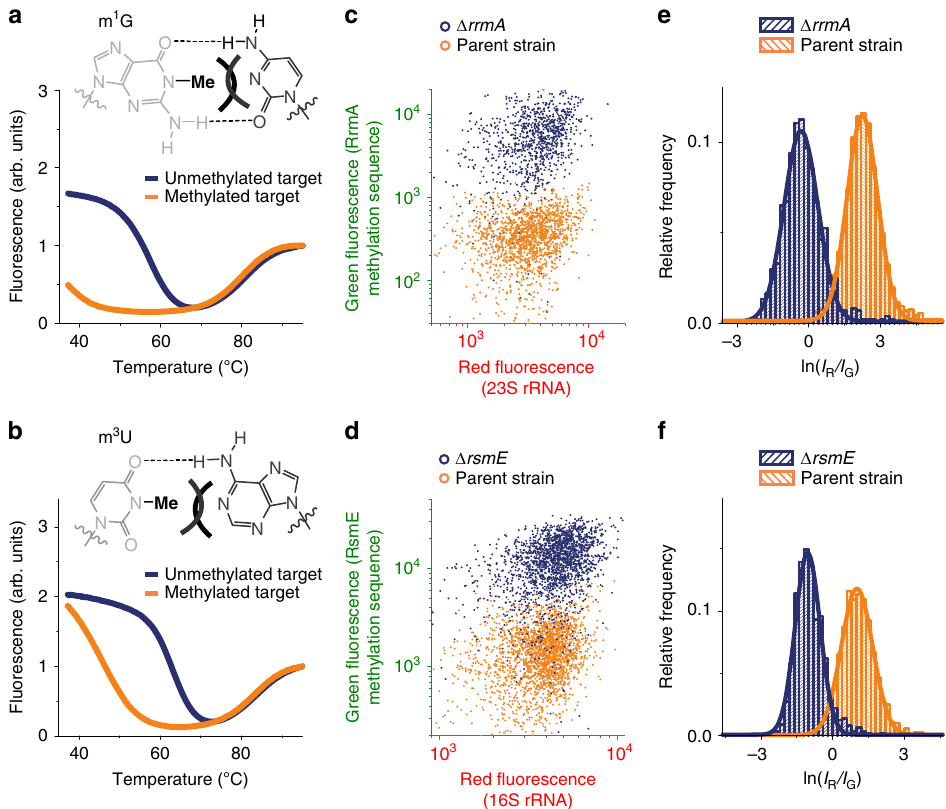
Fig. 2 MR-FISH can detect single methylated m 1 G and m 3 U bases. Discrimination by Molecular Beacons between methylated and unmethylated synthetic RNA target sequences of a RrmA and b RsmE. Scatter plots of red and green fl uorescence intensities of bacteria stained by MR-FISH using hybridization probes for RrmA ( c ; n = 1567 (parent strain) and 966 ( Δ rrmA ) cells) and RsmE ( d ; n = 2266 (parent strain) and 1894 ( Δ rsmE ) cells) modi fi cations. Log- normally distributed ratios of red fl uorescence intensity ( I R ) to green fl uorescence intensity ( I G ) of bacteria stained by MR-FISH using hybridization